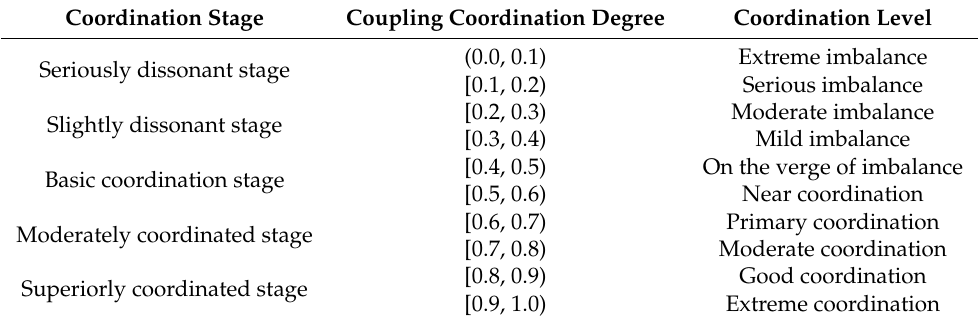
Table 3. Classification standard of coupling coordination